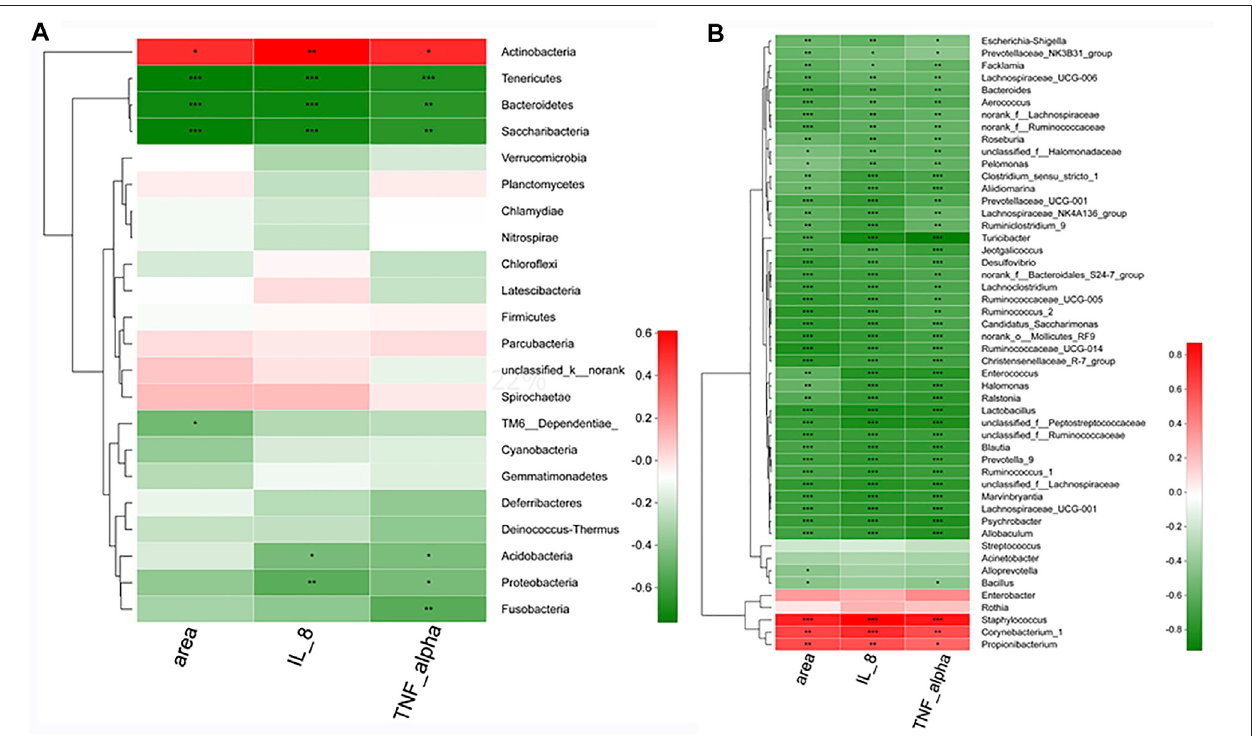
FIGURE 11 | The correlation between microbes and vital pathologic parameters linked to acne. At the phylum level (A) and at the genius level (B) . n = 8 rats per group. *.01 < p < .05, **.001 < p ≤ .01, *** p ≤ .001.